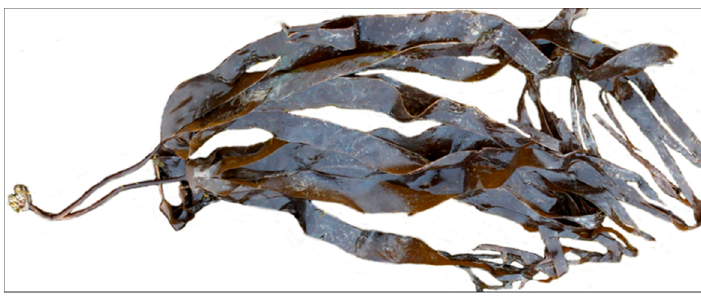
Figure 2. Kelp ( Laminaria digitata ; accessed at https://eol.org).